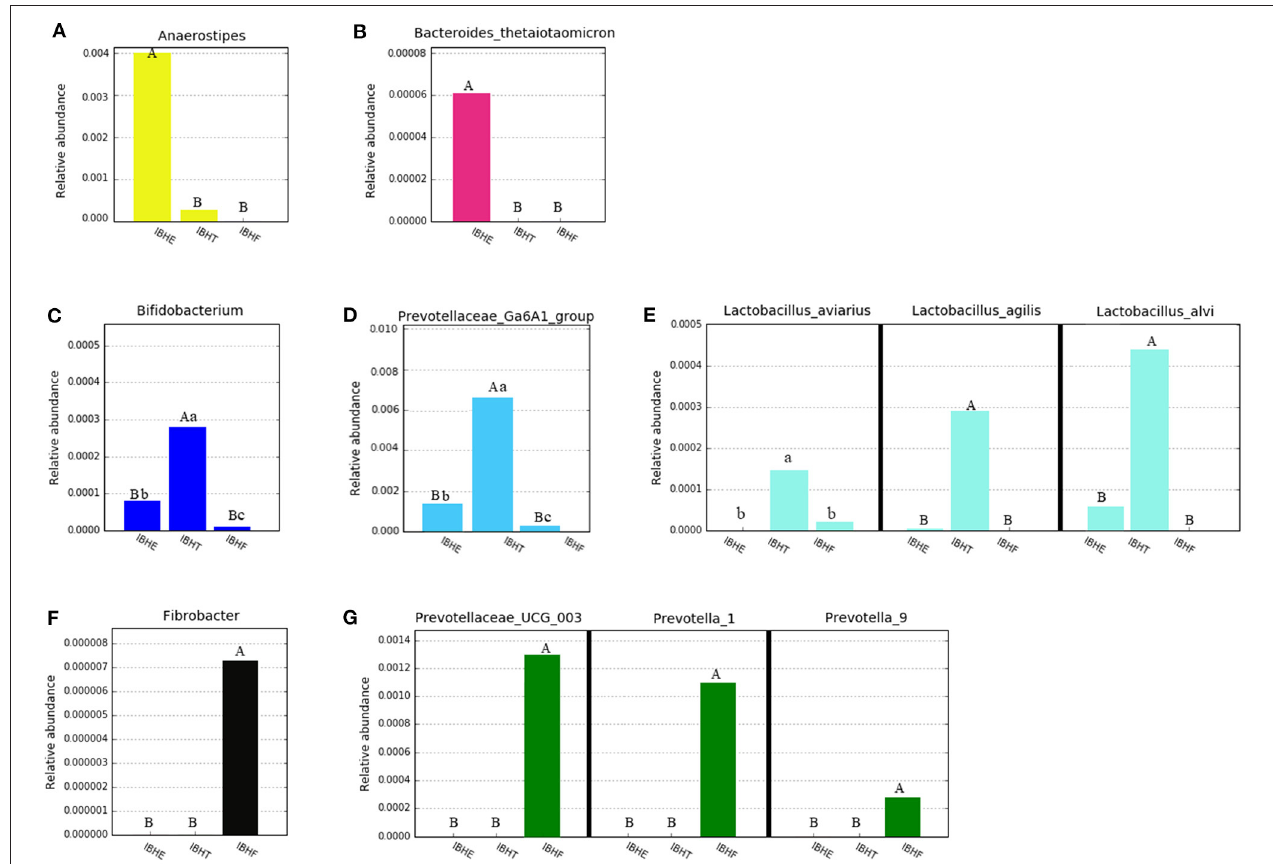
FIGURE 5 | Abundance histograms of some low-abundance dominant bacteria of chickens in different growth periods. (A,B) Abundance histograms of significant dominant short-chain fatty acid (SCFA)-producing bacteria Anaerostipes and fiber-degradation bacteria species Bacteroides thetaiotaomicron at 8 weeks. (C–E) Abundance histograms of significant dominant fiber-degradation bacteria genera Prevotellae_Ga6A1_group and Bifidobacterium and SCFA-producing species of Lactobacillus at 20 weeks. (F,G) Abundance histograms of dominant fiber-degradation bacteria genera at 50 weeks. Bacteria with different superscript letters mean significant differences ( P < 0.05) between groups, and different superscript letters mean extremely significant differences ( P <